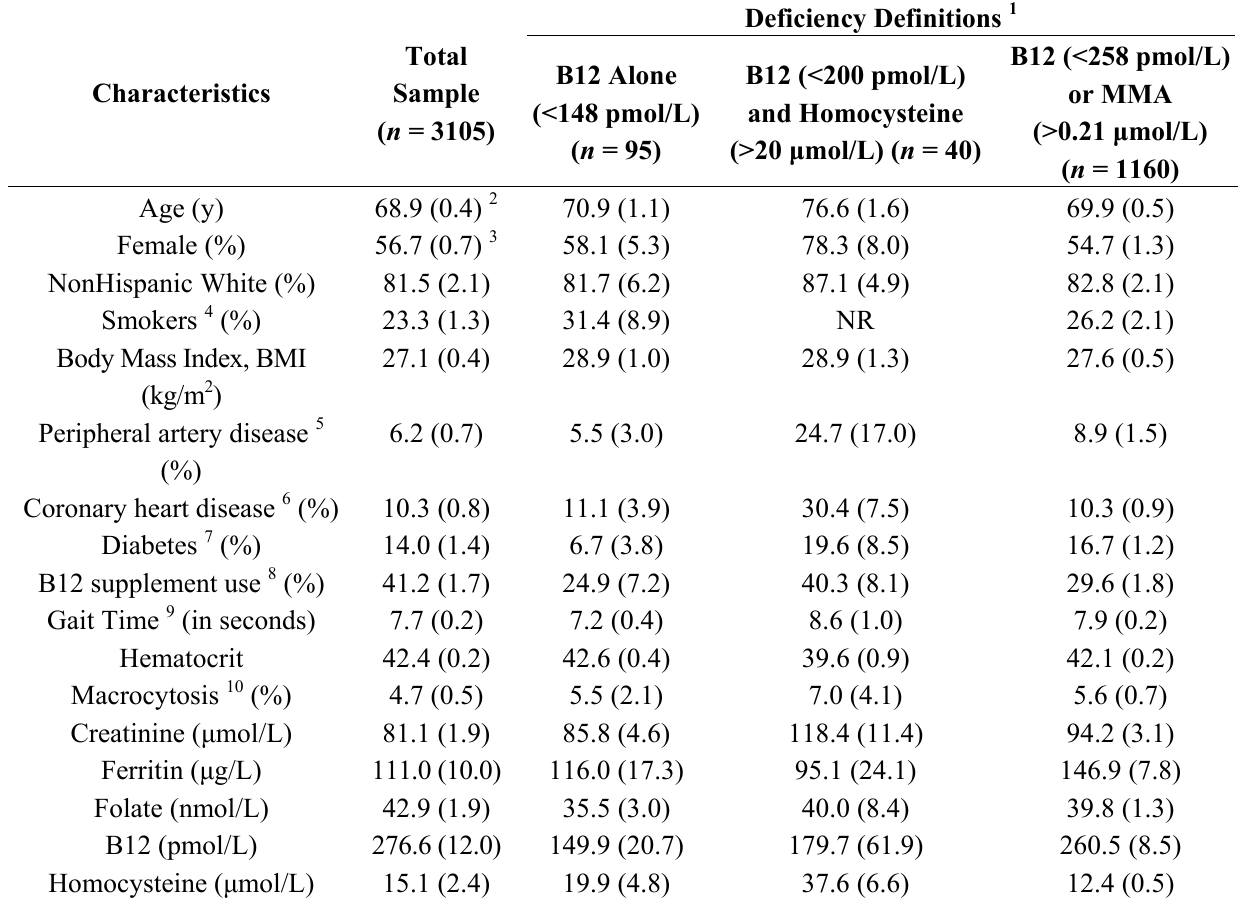
Table 1. Demographic characteristics of all National Health and Nutrition Examination Surveys (NHANES) 1999–2002 participants 60 years and older in the analytic sample and those classified as vitamin B12 deficient on the basis of three different